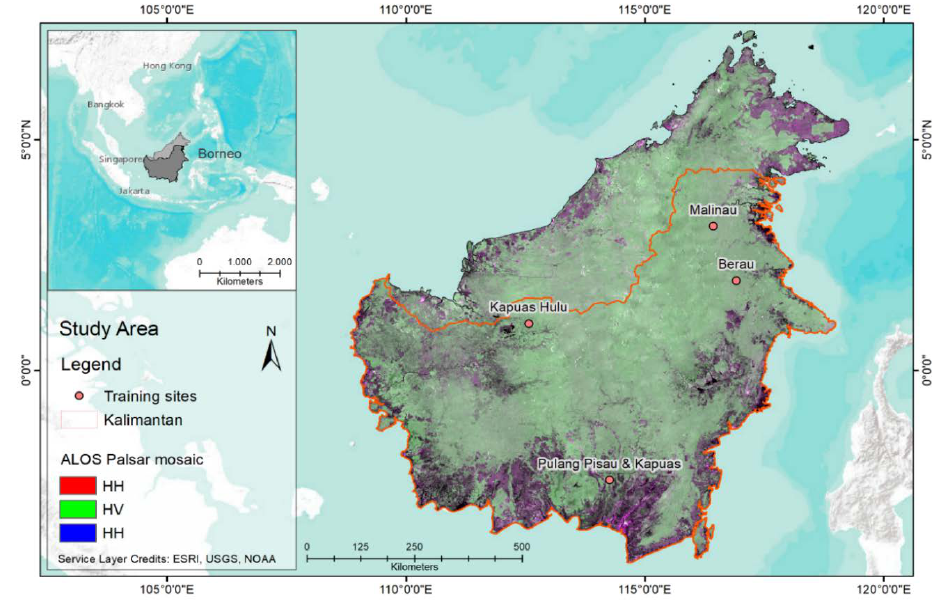
Figure 1. ALOS PALSAR false-color composite of Borneo Island using cross- and co-polarization as RGB (HH; HV; HH). To achieve the full coverage of Borneo 21 images of the year 2009 are mosaicked.